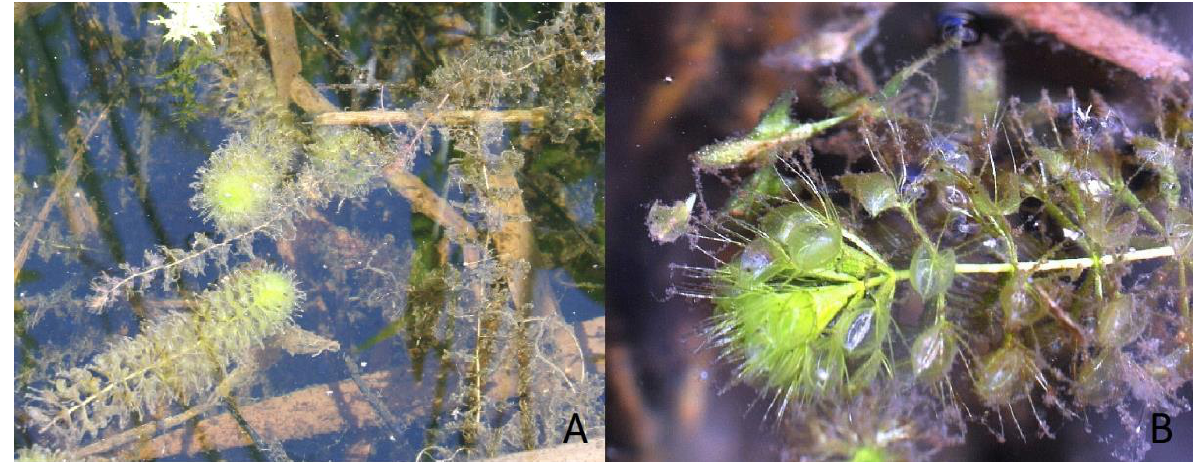
Figure 1. ( A , B ) Aldrovanda vesiculosa plants floating below the water surface.